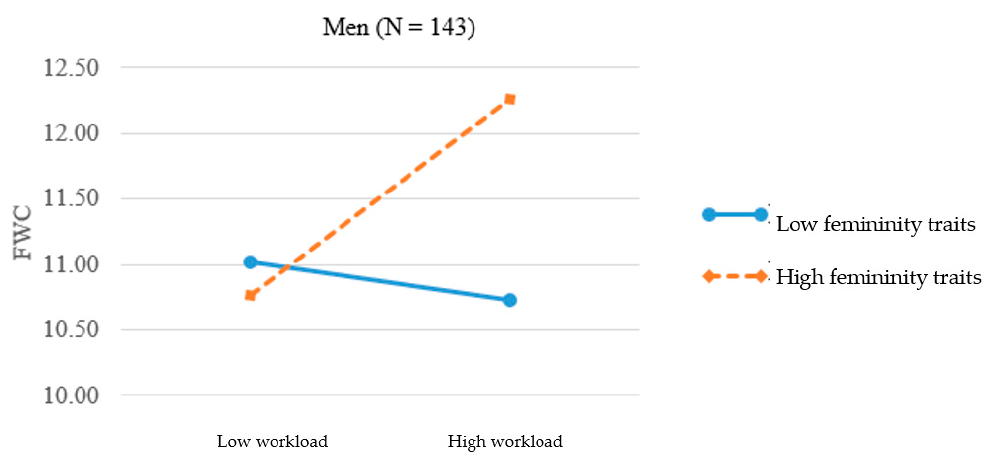
Figure 1. Interaction of femininity traits and workload on FWC for men.